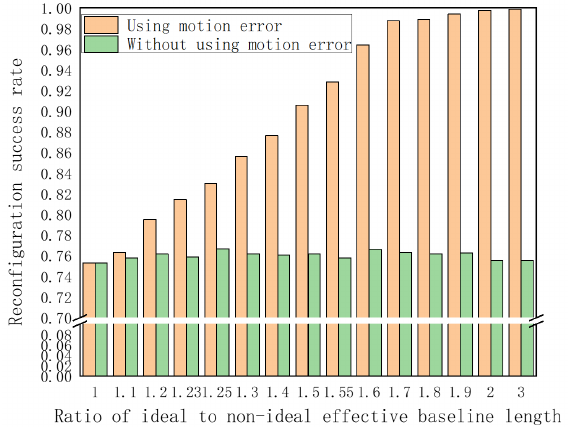
Figure 10. Performance evaluation of the proposed